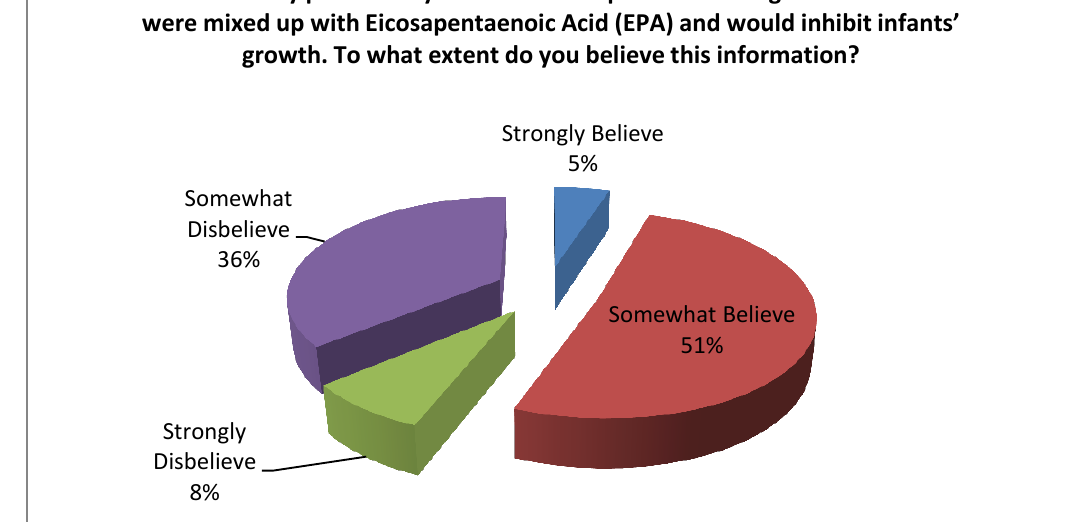
Figure 2: Trust / distrust in information circulated in social